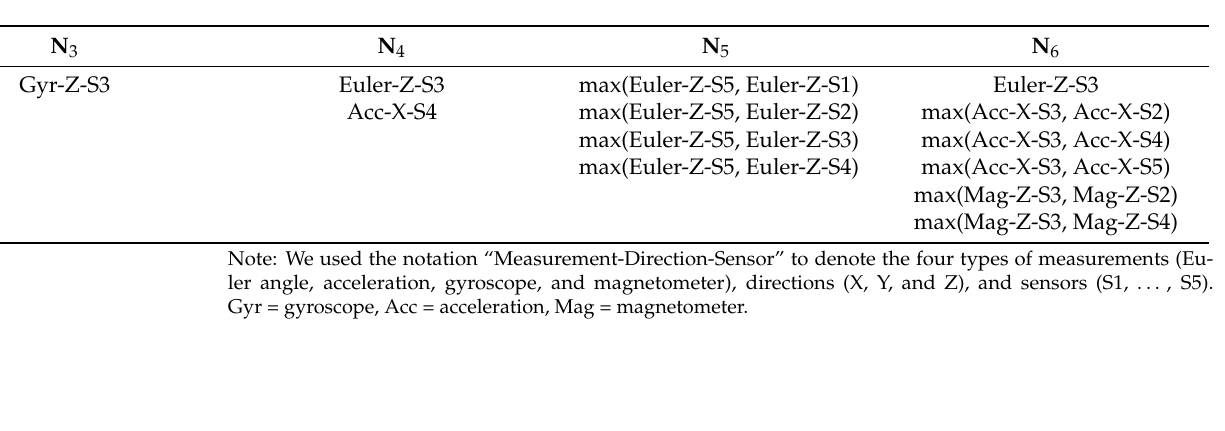
Table 3. Filtered variables for the nodes N 3 , N 4 , N 5 , and N 6